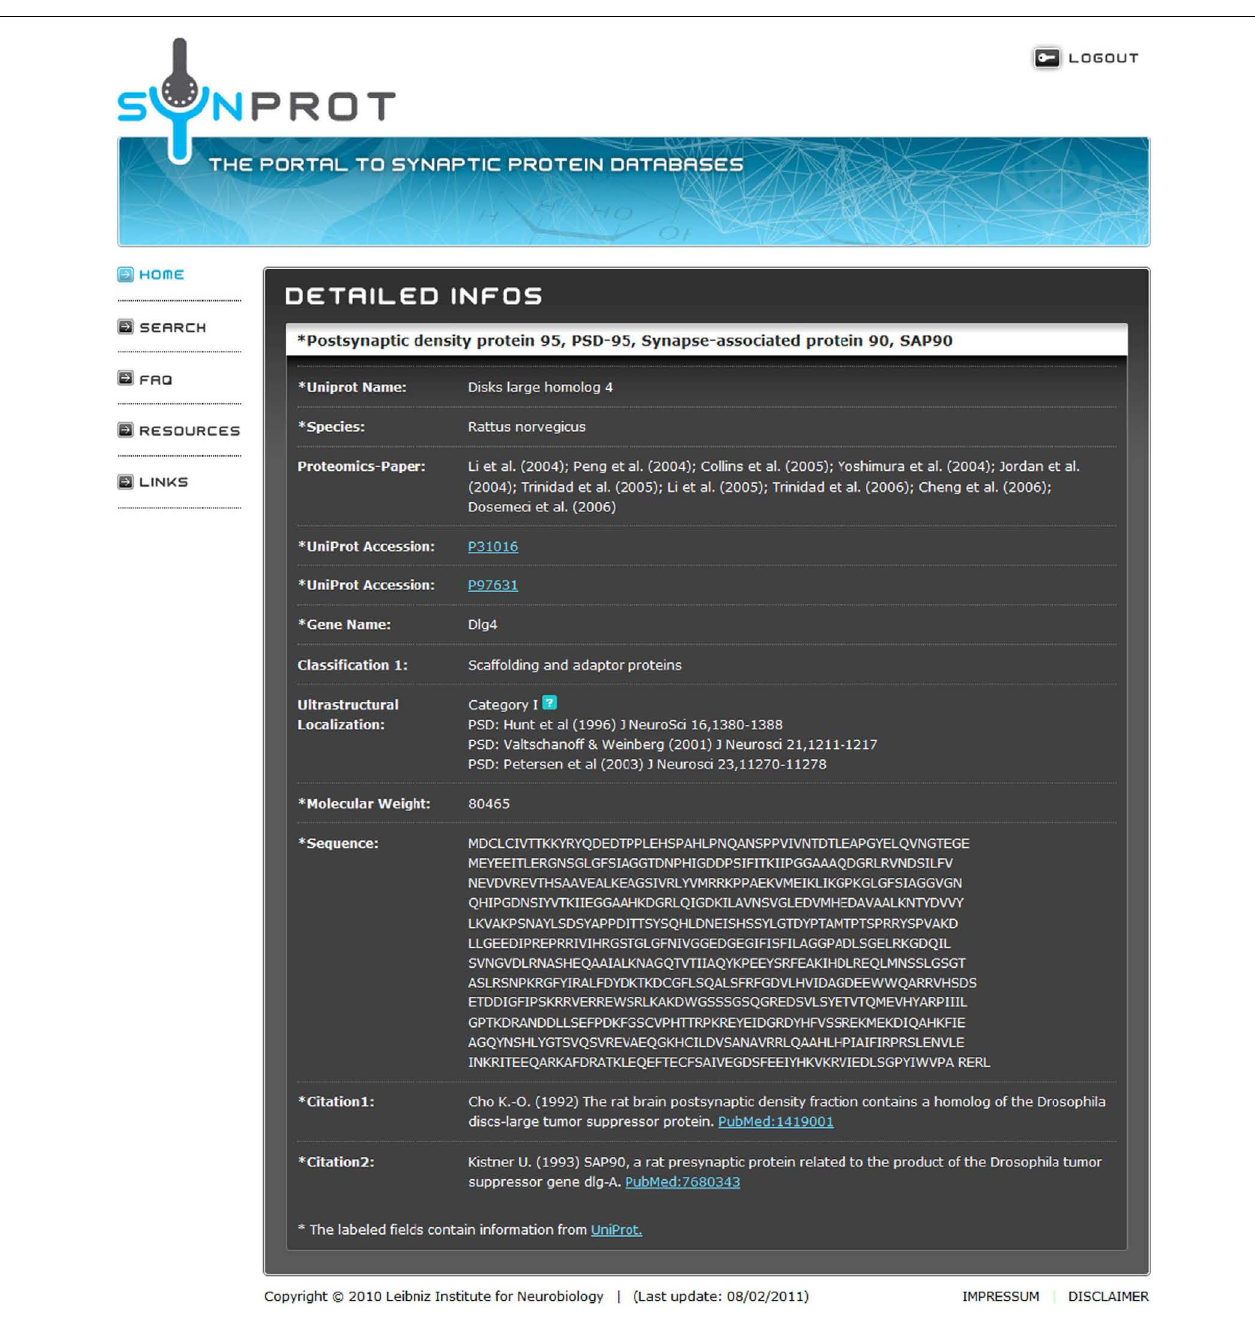
“Ultrastructural Localization” shows studies, in which the localization of this protein was verified by immunogold-staining. In addition, some of the proteins were manually assigned to categories, which denote the localization (see Table 4 ). All other data were retrieved from